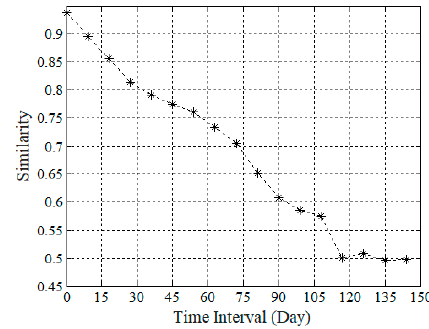
Figure 6. Temporal similarity in a sensor’s readings.